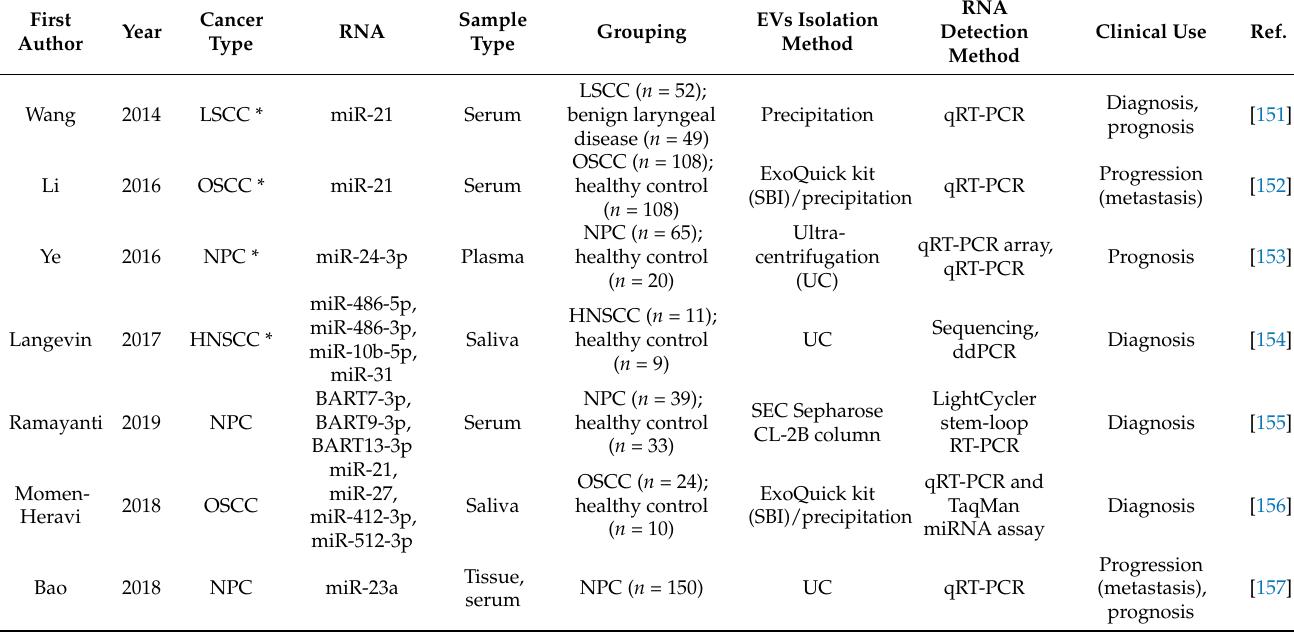
Table 1. The performance of EV-miRNA in the diagnosis, progression, prognosis prediction and treatment evaluation of